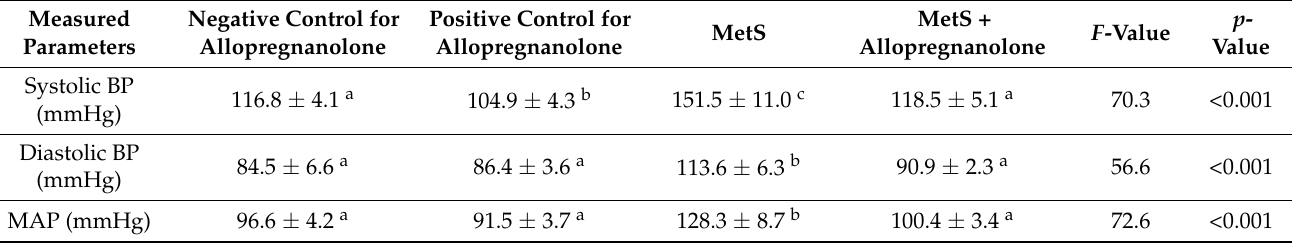
Table 3. Arterial blood pressure measurements in the studied